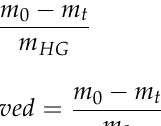
Figure 5. Molecular structures of ( A ) Indigo Carmine and ( B ) Cibacron Brilliant Yellow. At fixed time points, the sampling was performed, each time taking 1 mL of the solution, which was then put back again in the system after the analysis. The mass of the adsorbed dye per unit of mass of adsorbent material, defined sorption capacity q , and the percentage of dye removal, were evaluated at each time through Equations (1) and